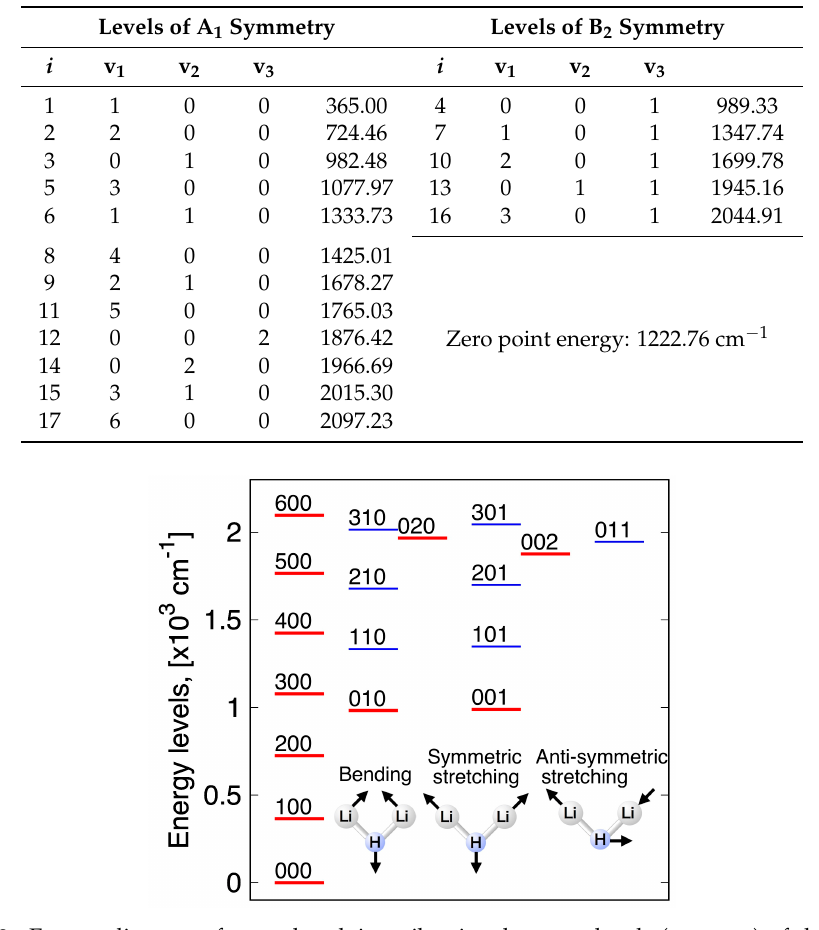
Table 4. MULTIMODE V-CI energies (cm − 1 ) of the low-lying vibrational energy levels (below the barrier to linearity) relative to the zero-point energy of nonrotating Li 2 H, using the local PES (see text). Levels of A 1 Symmetry